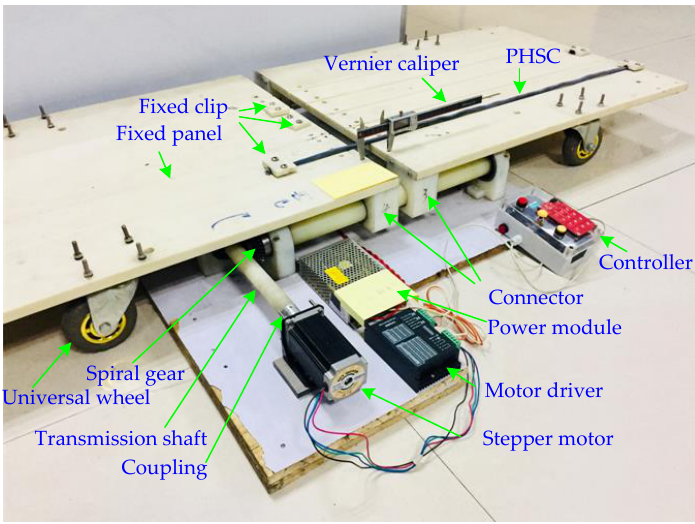
Figure 7. The PHSC tensile test platform.